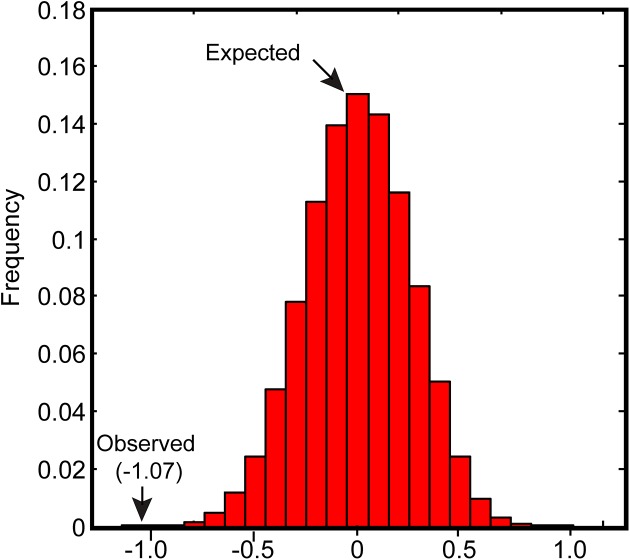
The observed differences in average FF values between the ER and NER groups are statistically significant.The x-axis shows the average FF difference between the ER group and the NER group in 10,000 random simulations. The y-axis indicates the number of simulated FF differences in a bin of width 0.1.